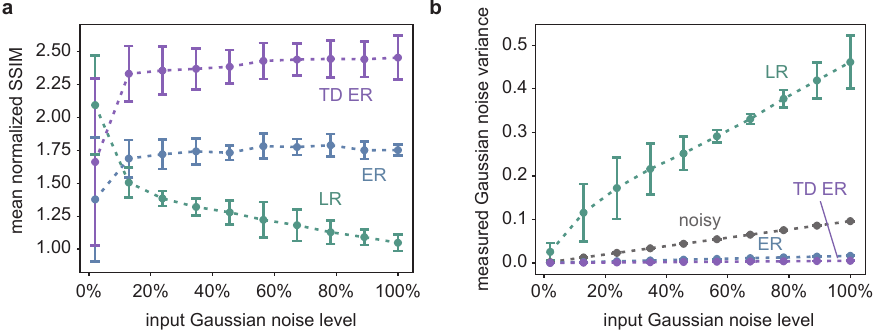
Figure 2. ( a ) The SSIM of the different image restoration methods, averaged over all time frames of 25 different, randomly generated synthetic datasets, such as the one in Figure 1a, normalized with respect to the SSIM between the noisy and the original image as a function of the input Gaussian noise. Thus, a value larger than one indicates image quality improvement compared to the noisy input image. The measurement points correspond to the average values obtained for three different Poisson noise levels, and the error bars indicate the influence of varying the Poisson noise levels in terms of the standard deviation of the respective different simulations. TD ER SSIM values are significantly higher than ER values and ER SSIM values significantly higher than LR values, except for the smallest Gaussian noise level ( p < 0.05; paired, one-sided Wilcoxon signed-rank test with Bonferroni correction; based on the SSIM values of the random synthetic time series, with the values averaged over Poisson noise levels). ( b ) The results of the Gaussian noise estimation as a function of the input Gaussian noise for the different deconvolution methods as well as for the original noisy image, where the latter is pictured in greys and represents a plausibility check of the applied noise estimation approach. TD ER values are significantly lower than ER values and ER values significantly lower than LR values for all Gaussian noise